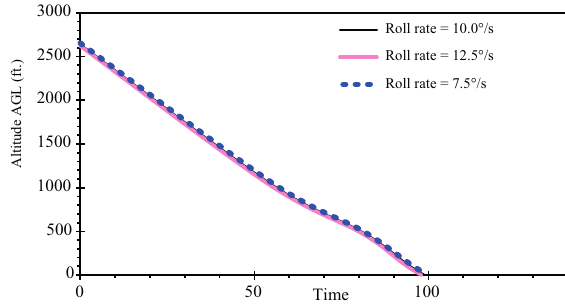
Fig. 6. Altitude above ground level vs. time for the optimum engines-out landing trajectory at 160 KCAS (no